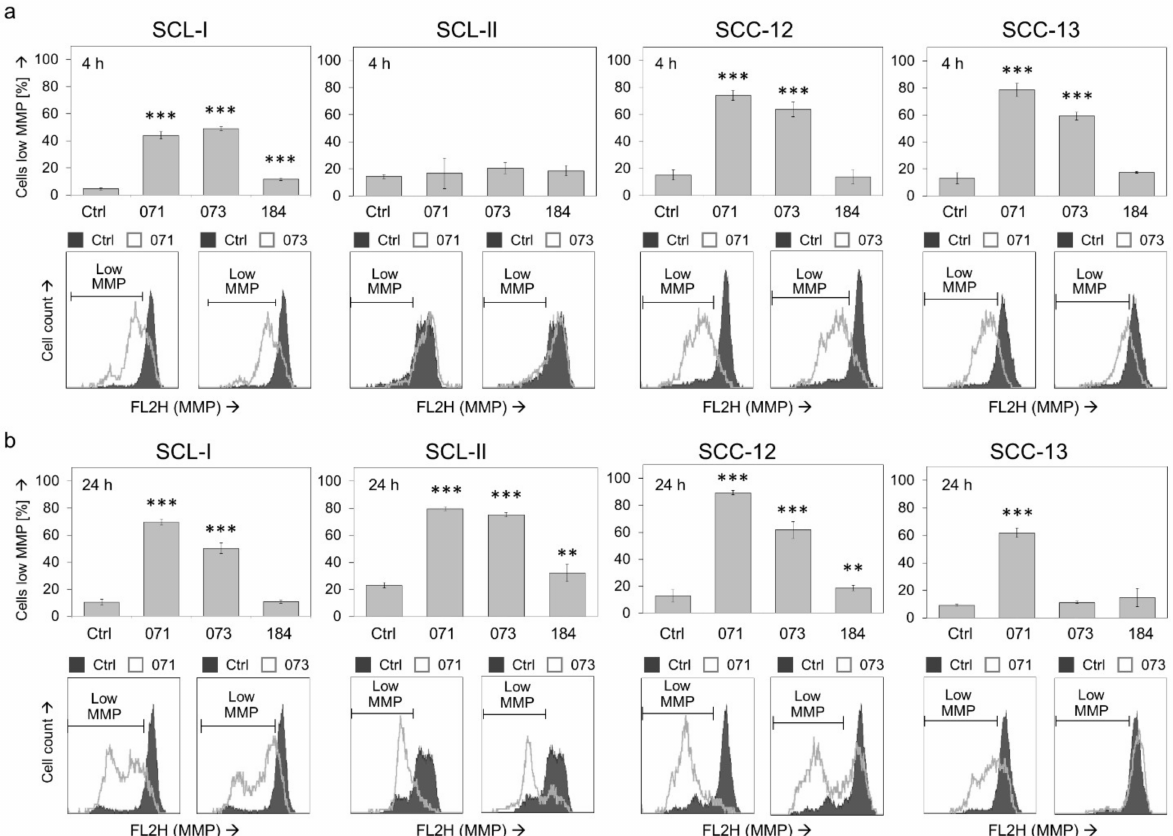
Figure 2. Loss of mitochondrial membrane potential (MMP). Percentages of cells with low MMP were determined by TMRM + staining at 4 h ( a ) and at 24 h ( b ) of treatment with indirubins (DKP-071, -073 and -184, 10 µ M) in four cSCC cell lines. Cells with low MMP are defined by less staining than the main peak of control cells. Example flow cytometry measurements of controls and treatments are provided below (overlays of treated cells vs. controls), and cell fractions with low MMP are indicated. Mean values and SDs are shown of a representative experiment (two independent experiments, each one with triplicates). Asterisks indicate statistical significance, as compared to controls (** p < 0.01; *** p <